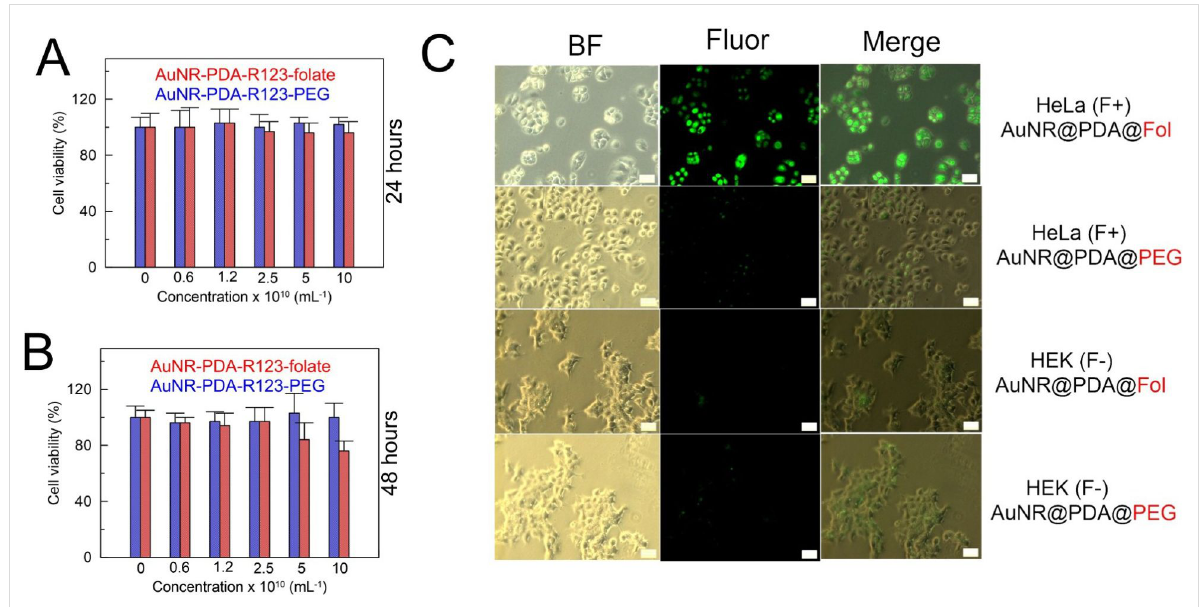
Figure 2: In vitro cell viability of HeLa cells incubated with various concentrations of AuNR-PDA-R123-folate or AuNR-PDA-R123-PEG after (A) 24 h and (B) 48 h of incubation. (C) The microscopy images of HeLa (F+) and HEK 293 (F − ) cells after treatment with AuNR-PDA-R123-folate or AuNR- PDA-R123-PEG for 2 h. BF: bright-field imaging; Fluor: fluorescence imaging.